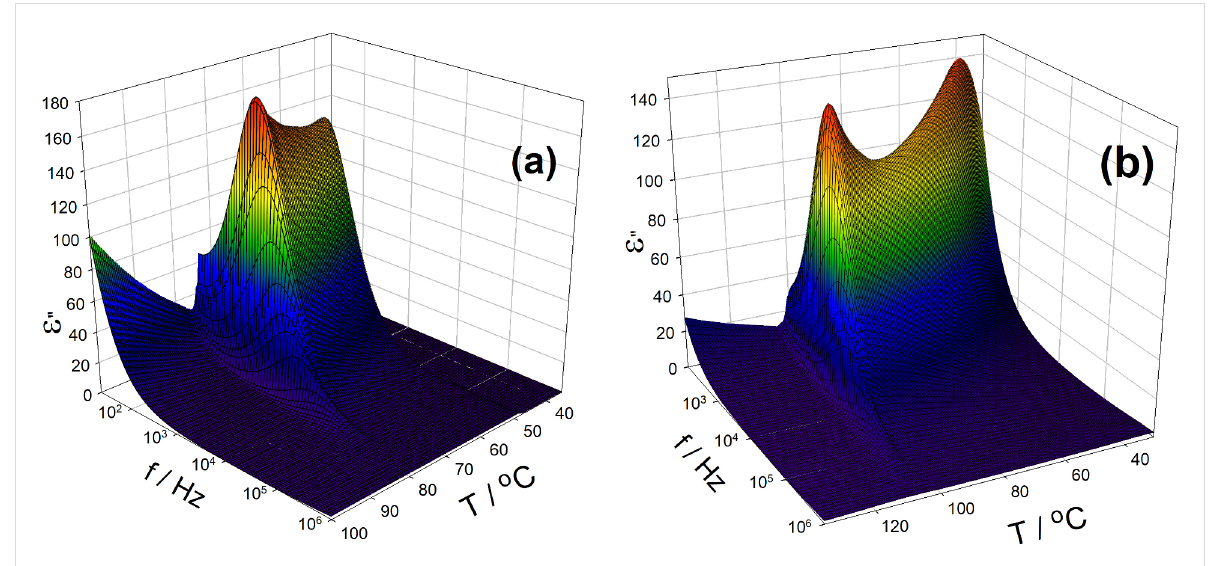
Figure 4: 3D plots of the imaginary part of complex permittivity for KL 3/4 (a) and KL 4/4 (b) showing strong contributions of the Goldstone mode within the temperature range of the tilted ferroelectric SmC* phase.